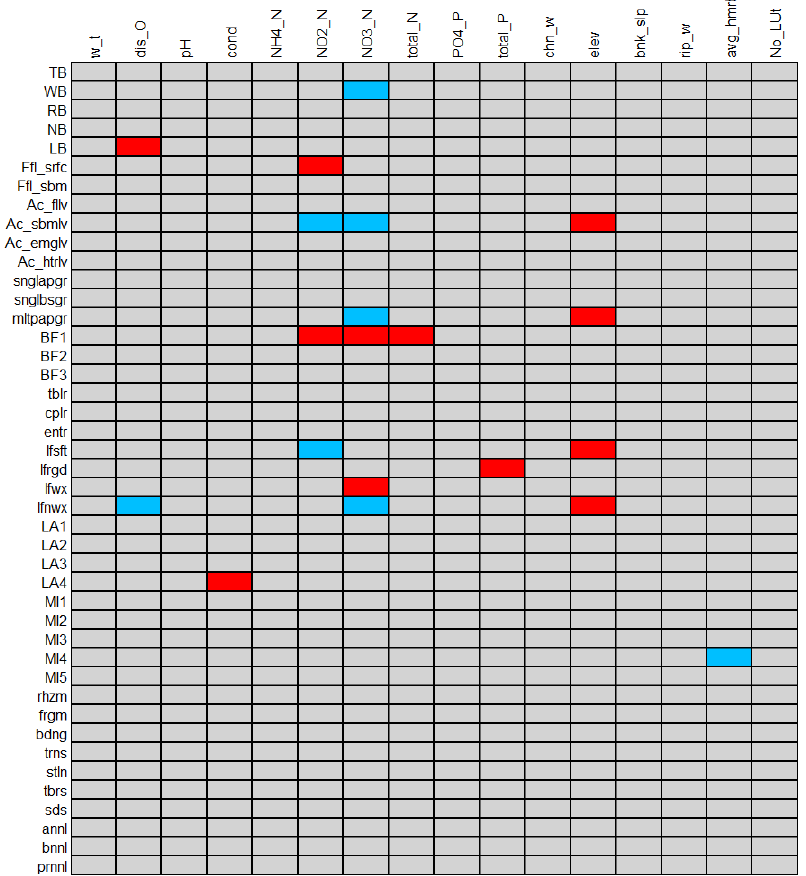
Figure 4. Results of the fourth-corner tests, corrected for multiple testing using FDR procedure. At α = 0.05 level, significant positive associations are represented by red cells and negative ones by blue cells. The abbreviated names of environmental variables are given in Table 1, and those of functional traits in Table 2.